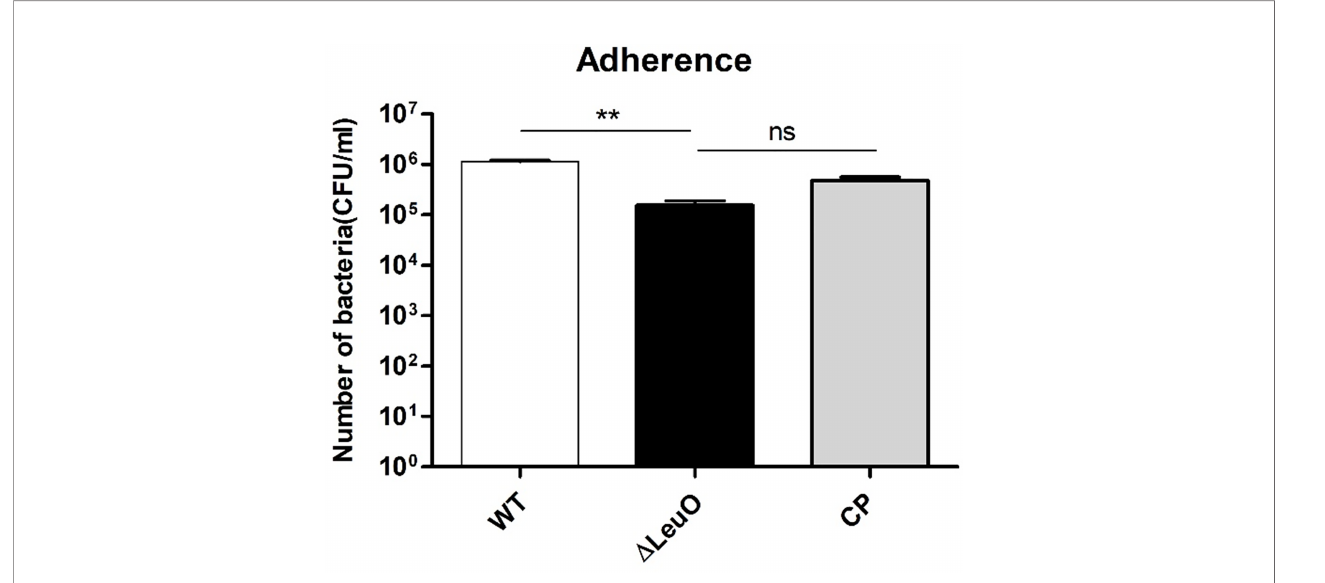
FIGURE 6 | Adherence of A. baumannii strains to A549 cells. A549 alveolar epithelial cells were infected with A. baumannii wild-type, D LeuO, .and CP strains at a MOI of 1:100 for 2 h. After lysis with Triton-X, cell lysates were diluted and plated onto LB agar plates for CFU counting. The experiment was performed with three replicates. Data are presented as mean ± SD. ns, non-signi fi cant; **P < 0.01, signi fi cantly lower than that of the wild-type